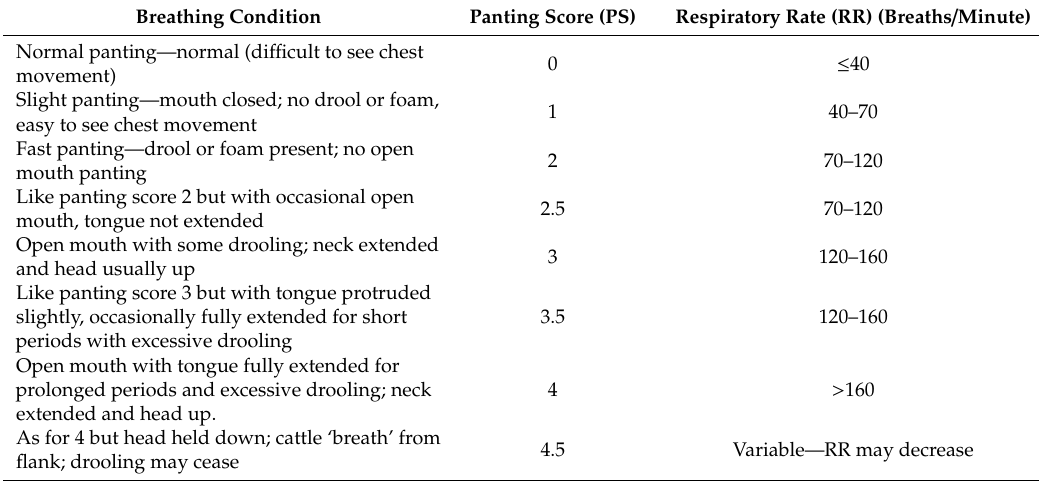
Table 1. Scale used for respiratory rates and panting scores (adapted from Gaughan et al. [26]). Breathing Condition